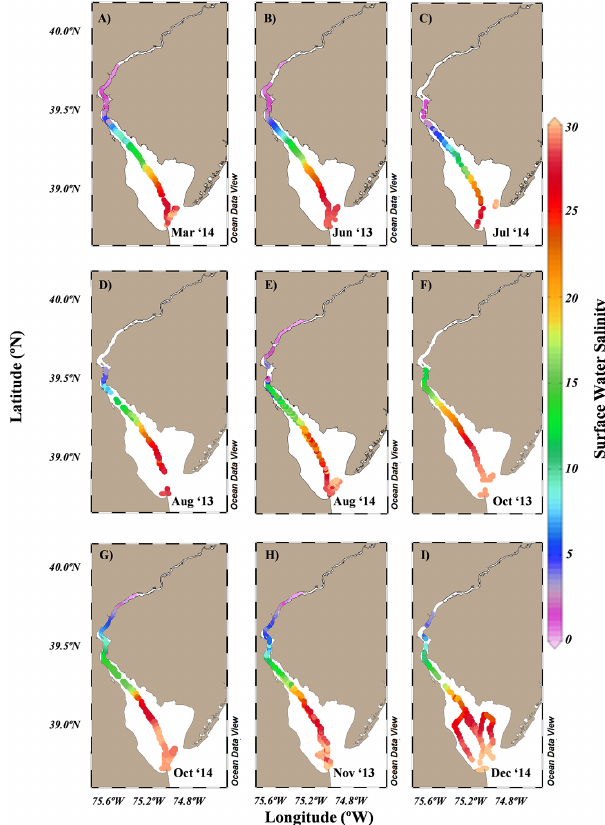
Figure 5. Spatial distributions of surface water salinity in the Delaware Estuary measured during each sampling month. The map was designed with the ODV software by R. Schlitzer (Ocean Data View software, 2015,